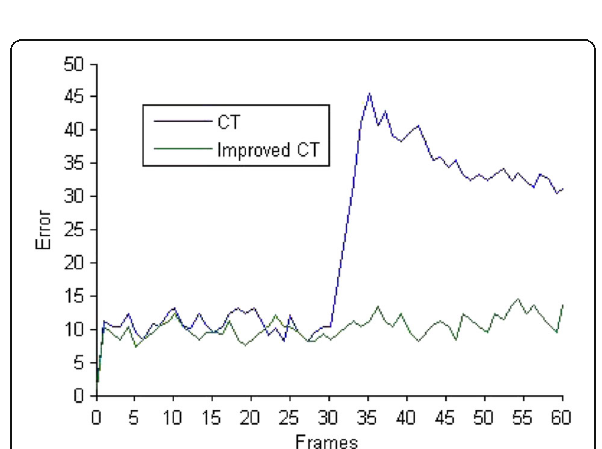
Fig. 13 The tracking error of the first 60